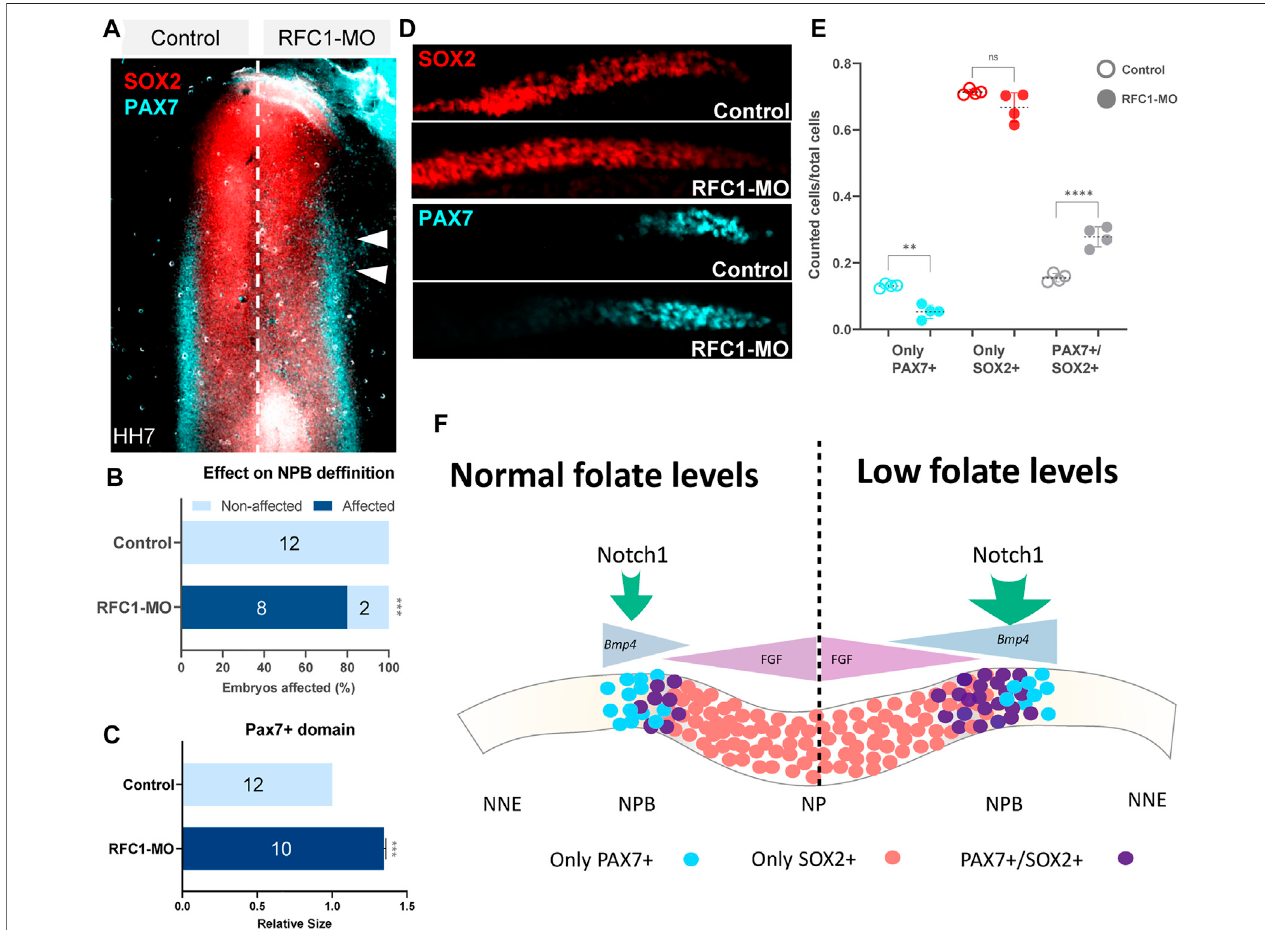
FIGURE 6 | Folate carrier de fi ciency enhances the potentiality of the NPB cells. (A) Whole mount immunohistochemistry of PAX7 (neural plate border marker) and SOX2 (neural marker) in the RFC1-MO and control-MO treated embryos. White arrowhead pointed out ectopic expansion of PAX7+ cells. (B) Quantitation of embryos electroporated with RFC1-MO ( n =10) presenting ectopic expression ofPAX7+ cells and comparing with control-MO ( n = 10) treated embryos. (C) Quanti fi cation ofthe relativesizeofPAX7+cellsdomainobservedin (D)(D) TransversalsectionsofthetreatedembryosfollowedbyIHCagainstSOX2andPAX7markers.Orientationof control sides hasbeen fl ipped for comparison. (E) Scatterplot ofquanti fi cation ofcells that exclusivelyexpressing PAX7+, SOX2+, or coexpressing both PAX7+/SOX2+ on RFC1-MO and control embryos. Statistical analysis in B chart was performed by the contingency table followed by Fisher ’ s exact test (***: p = 0.0001). For (E) , Ordinary one-way ANOVA followed by Tukey ’ s multiple comparison test (**: p = 0.003, ****: p < 0.0001). (F) Schematic proposed model: Low levels of folate during the early stages of NPB development affect DNA methylation and expression of Notch1 , that leads to an increased and expanded Bmp4 expression. As consequence, a highernumberofprogenitorsina “ primed ” statearemaintainedduetothecoexpressionofboththeneuralandneuralplatebordermarkersattheirterritorial boundaries.